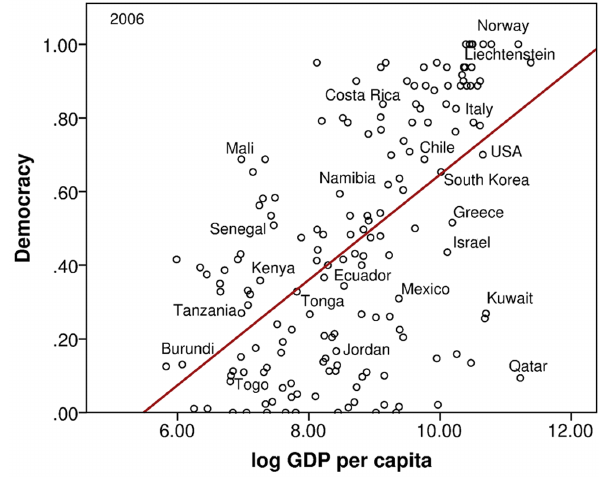
X 3 2 Figure 1. Country-based correlation scatter plot for log GDP